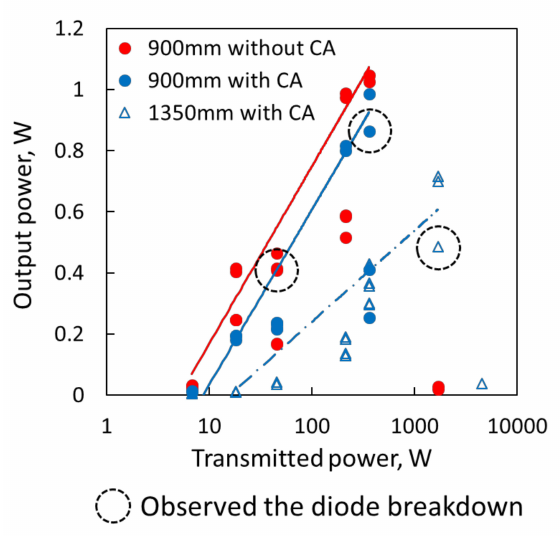
Figure 12. 25 array rectenna DC output power in a gyrotron WPT